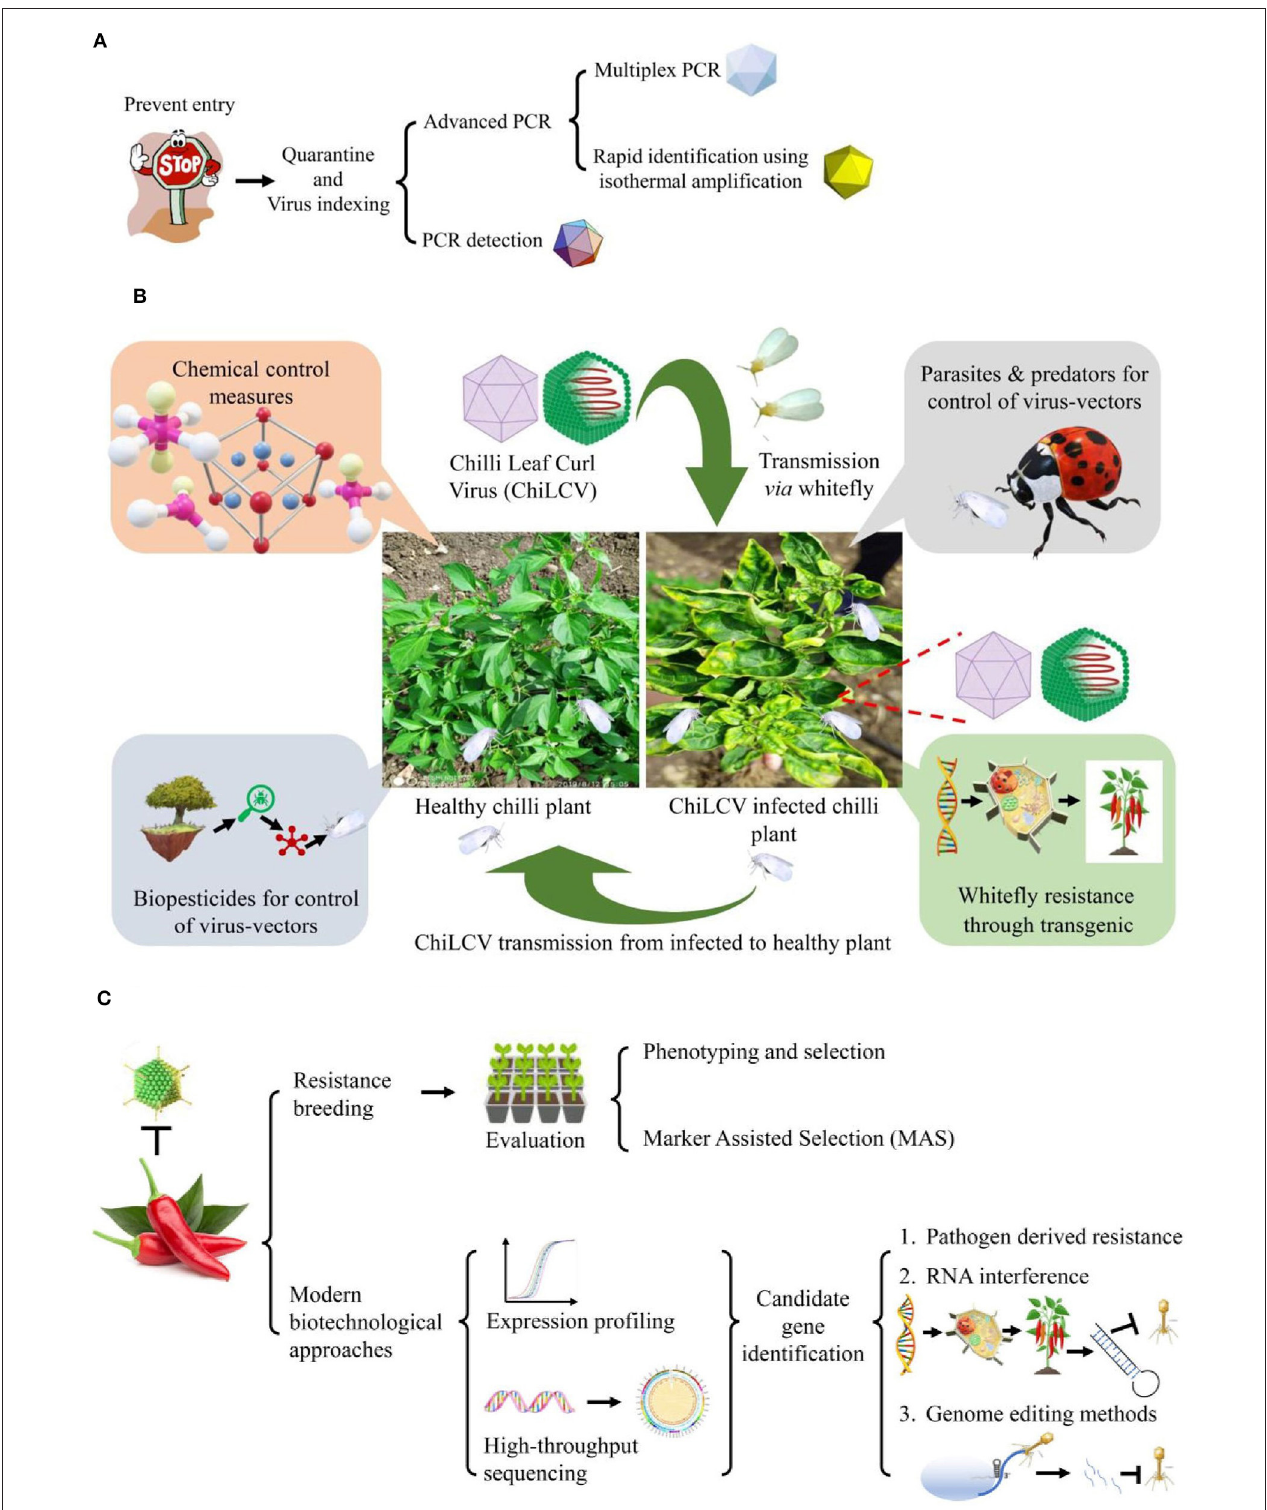
FIGURE 5 | Conventional and non-conventional strategies for management of chili leaf curl disease (ChiLCD) in chili. (A) Strategies for Chili leaf curl virus (ChiLCV) management, (B) strategies for management of ChiLCD through virus-vector control, and (C) strategies for improvement of ChiLCD resistance in chili.